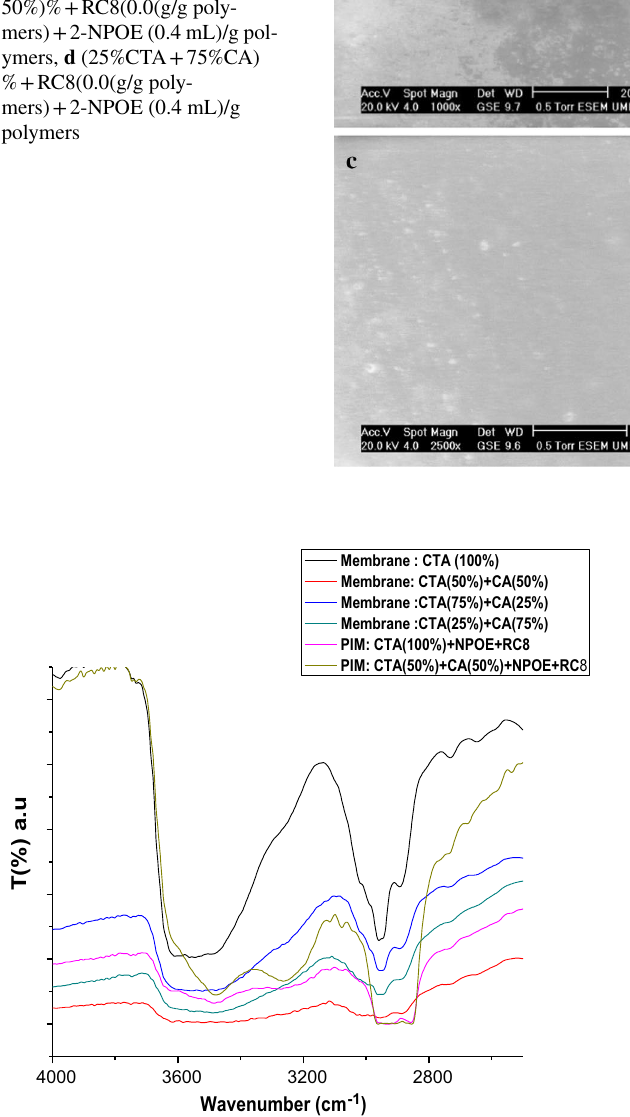
Fig. 4 FTIR spectra of PIMs